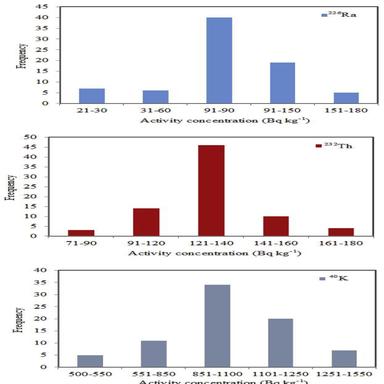
Frequency distribution of the activity concentration of radionuclides in the zeolite samples.